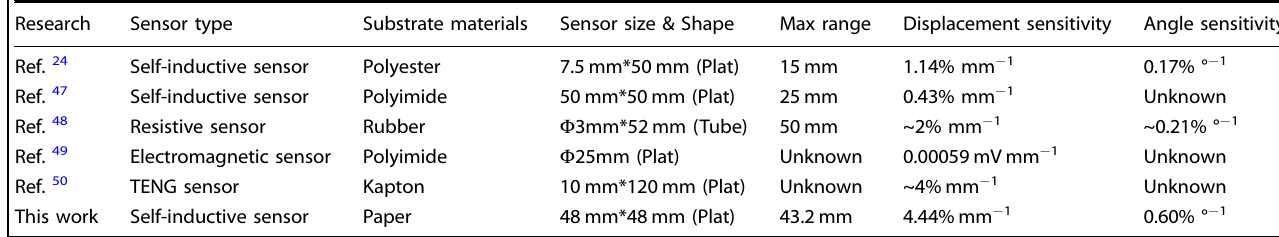
Table 1. The comparison of this work with other